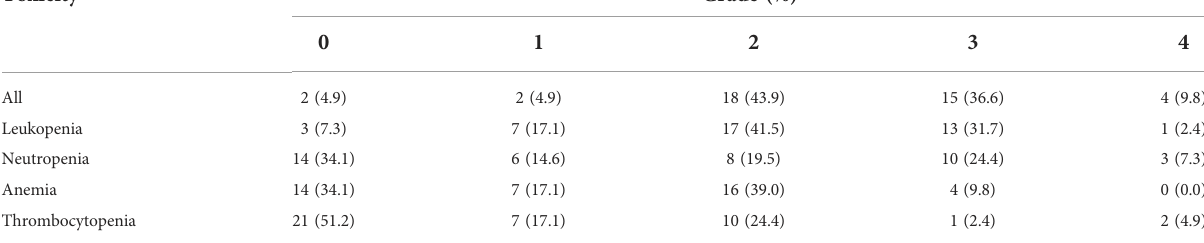
TABLE 2 Hematologic toxicity during